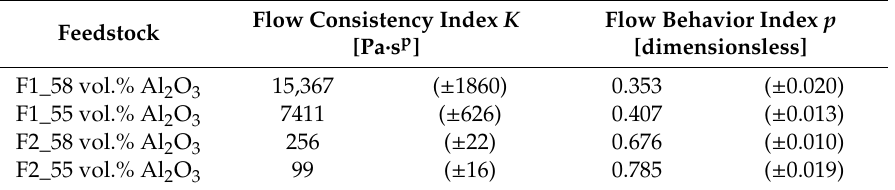
Table 3. Rheometrically determined indices of the Ostwald-de Waele relationship (Equation (1)) for molding compounds with di ff erent PVB- / PEG-ratios (Formula 1 and 2) and di ff erent powder loads.